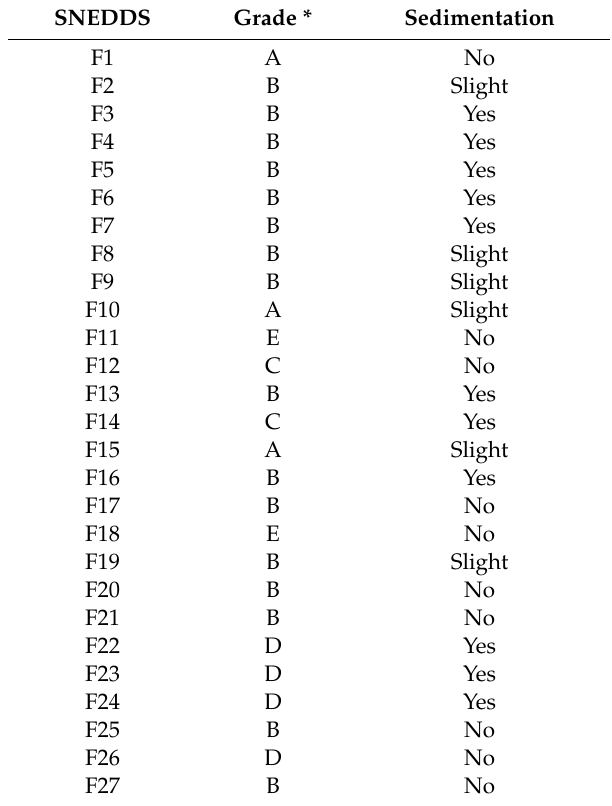
Table 1. The recorded optical observations of self nano-emulsifying drug delivery system (SNEDDS) 27 Formulations (F1–F27) based from their grade and sedimentation.